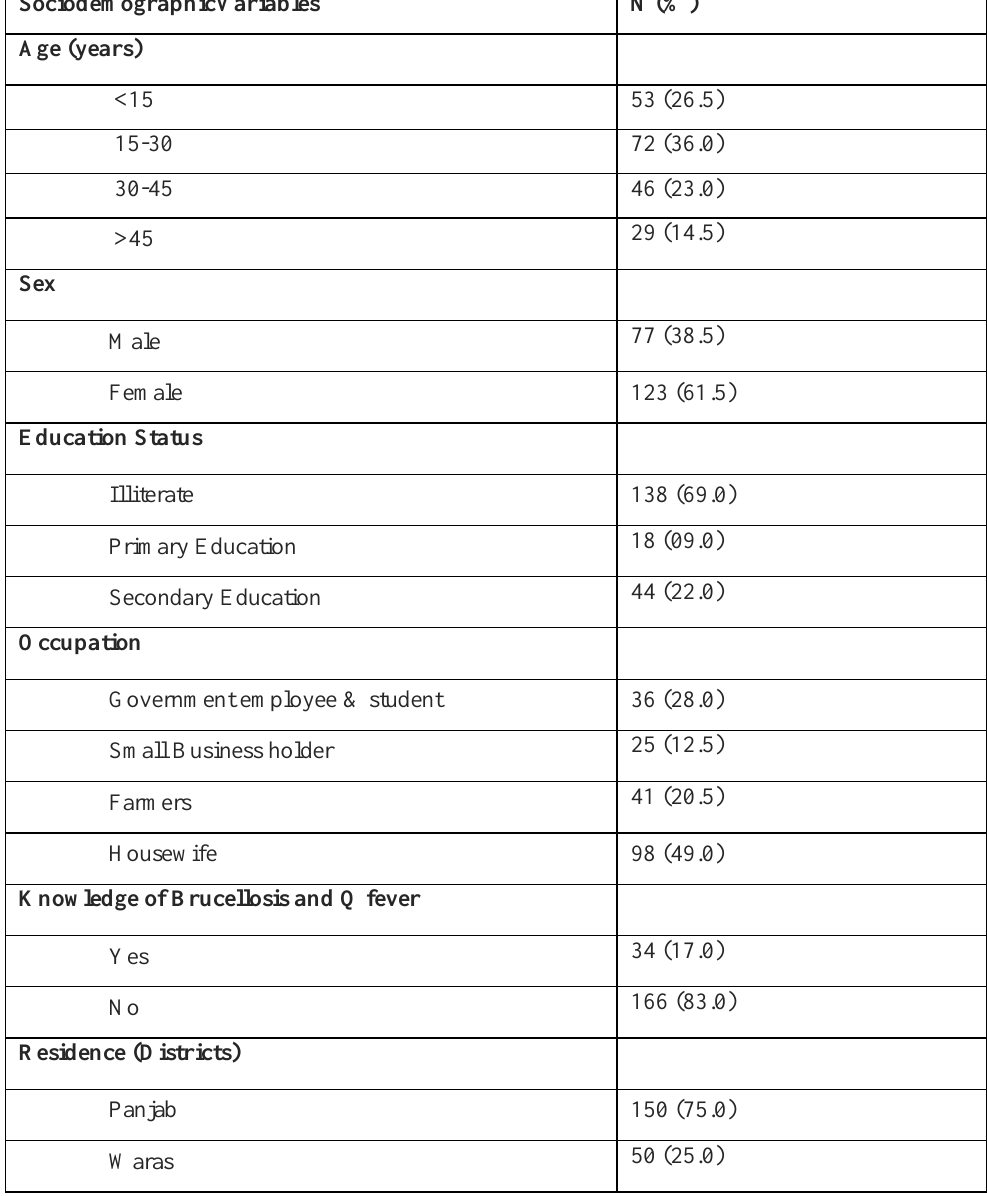
Table 1: Frequency distribution of the socio-demographic characteristics of study participants in Bamyan Province- Afghanistan in July 2011